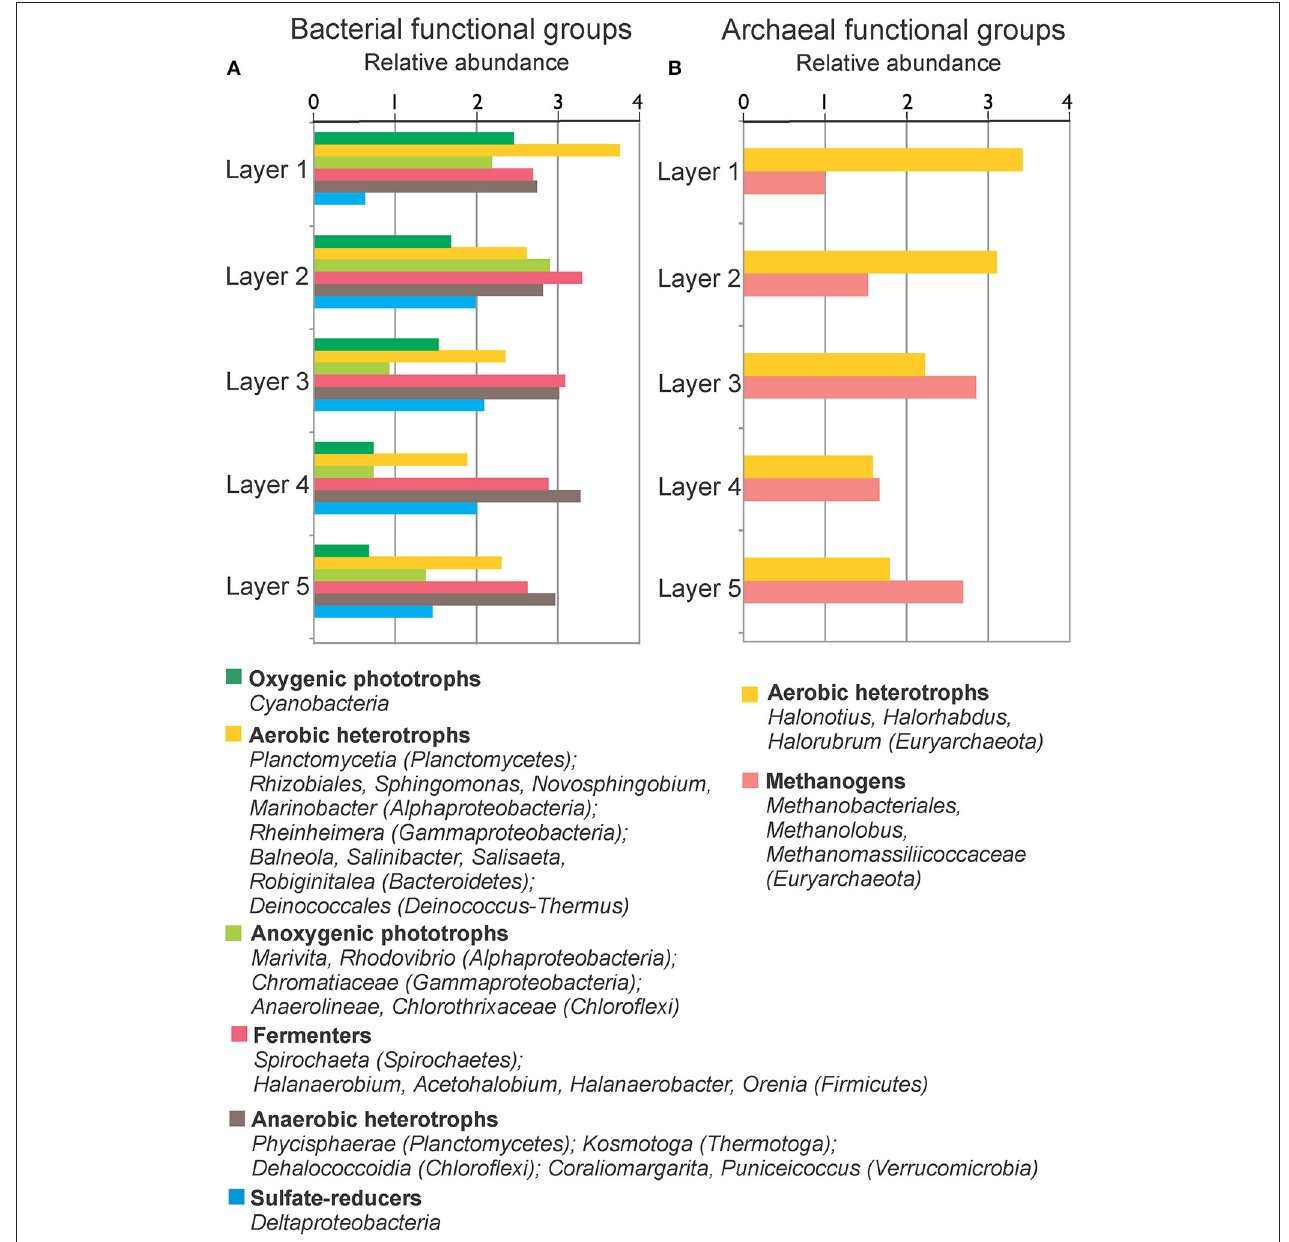
FIGURE 7 | Relative abundance (log 10 base) of bacterial (A) and archaeal (B) functional groups by layers in MA1. Functional groups are formed with the available metabolic information from the microorganisms present in the